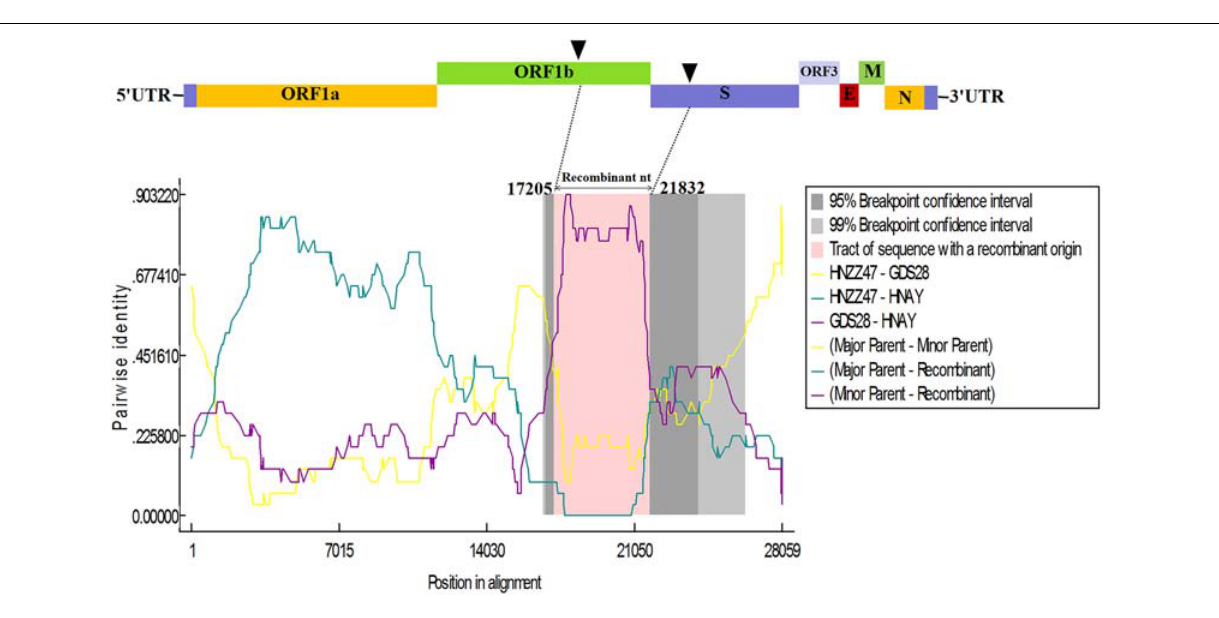
FIGURE 6 | Recombination analysis of PEDV HNAY with indicated PEDV strains. The result was described using RDP method which was supported by ≥ 6 programs to further characterize the potential recombination events. The black arrow indicates the regions where recombination event may